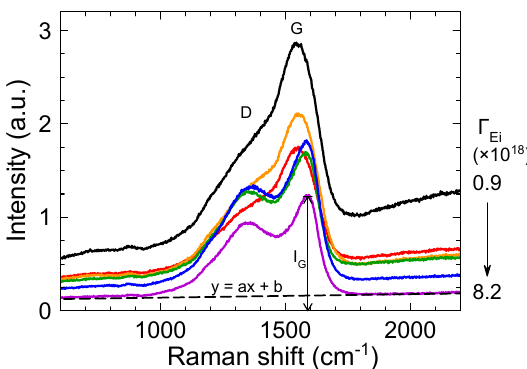
Figure 5. The Raman spectra of as-deposited a-C:H films. Top 3 spectra are a-C:H films deposited at 20 W in VHF power (black, orange, and red lines) and bottom 3 spectra are a-C:H films deposited at 250 W in VHF power (green, blue, and purple lines). The ion bombardment energy flux Γ E i are shown at the right and its value increase from top to bottom.